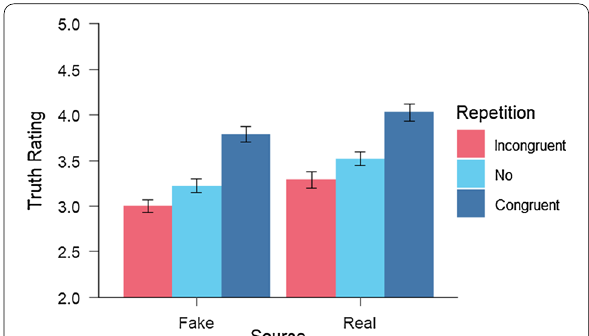
Fig. 5 Mean truth ratings in Experiment 4 as a function of source condition and repetition condition. Error bars represent standard error of the